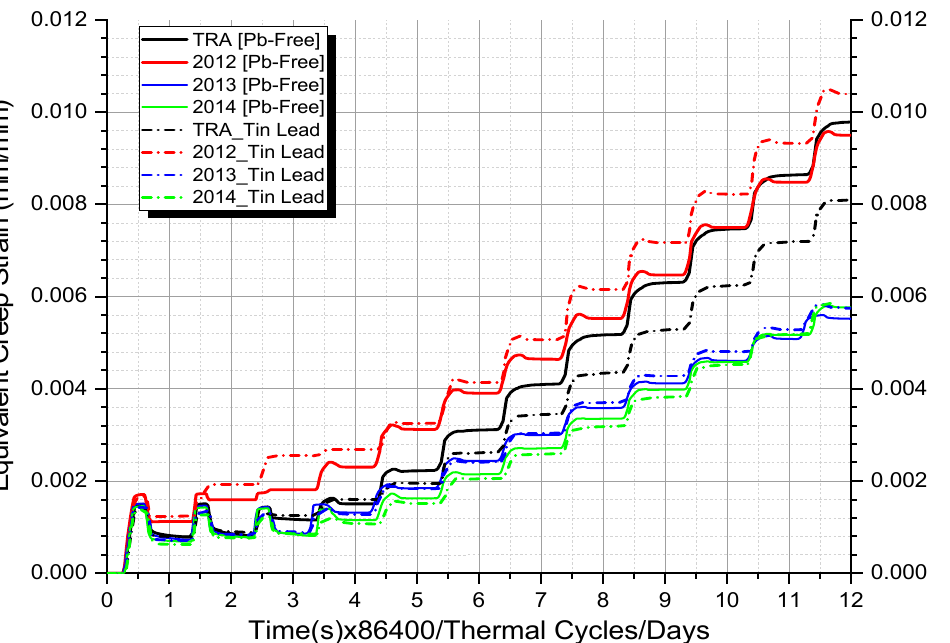
Figure 9. Superimposed plots of equivalent creep Strain versus Thermal Cycles. that creep damage is sensitive to the thermal cycle parameters. Overall, the 2012